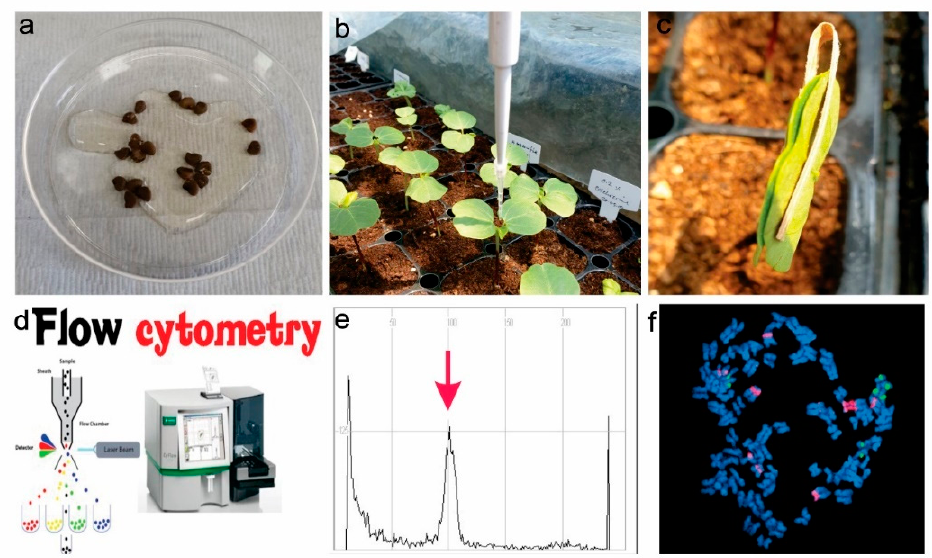
Figure 1. Mechanism of in vivo polyploidization; ( a ). Seeds soaking (6–24) hours with colchicine (0.01–0.2)%, ( b ). Colchicine treatment (10–20 µ L) 10 days in the young leaves, ( c ). Leaves binding with clips for maximum chemical attachment, ( d ). Flow cytometry analysis for ploidy level assessment, ( e ). Ploidy level assessment by a histogram, ( f ). Hibiscus ploidy assessment using chromosome number; and 5S rDNA (green) and 18 rDNA (red) signals.